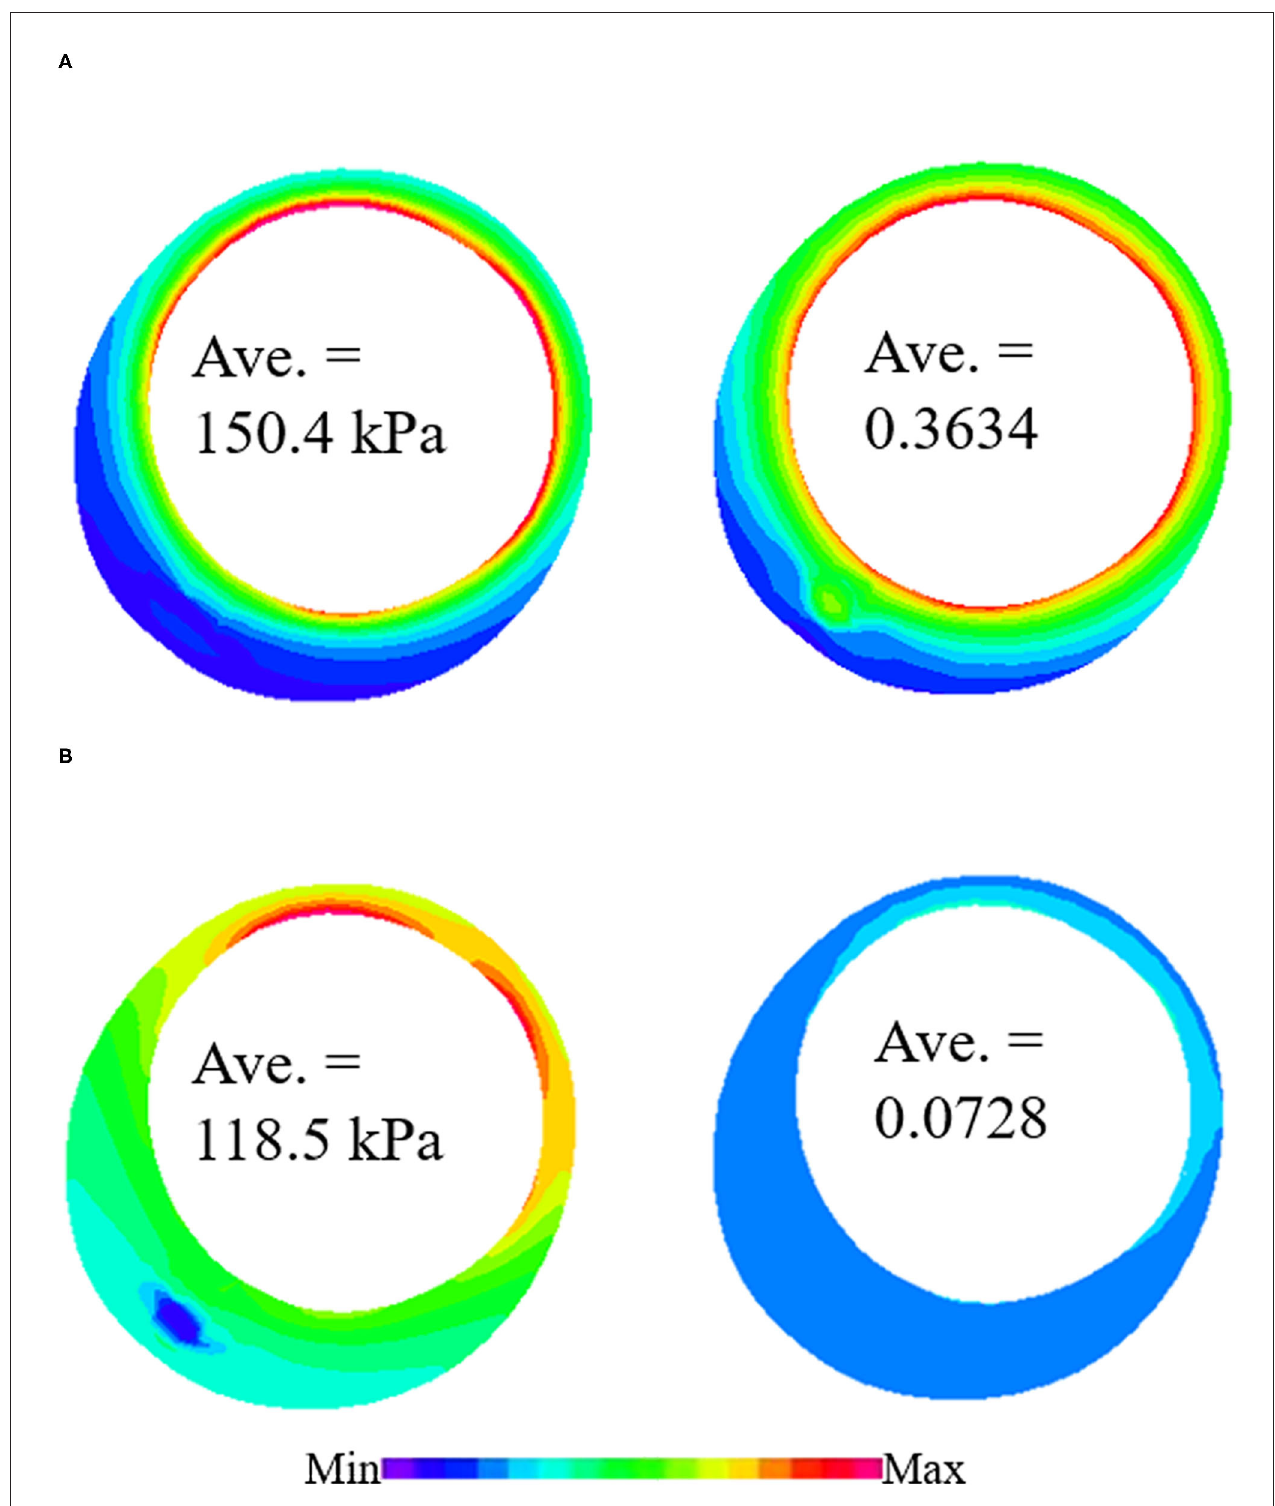
FIGURE 5 | Plaque wall stress/strain (PWS/PWSn) distributions from 3D thin-slice structure-only models with in vivo and ex vivo materials. (A) PWS/PWSn distribution from 3D thin-slice model with in vivo material. (B) PWS/PWSn distribution from 3D thin-slice model with in vivo material.